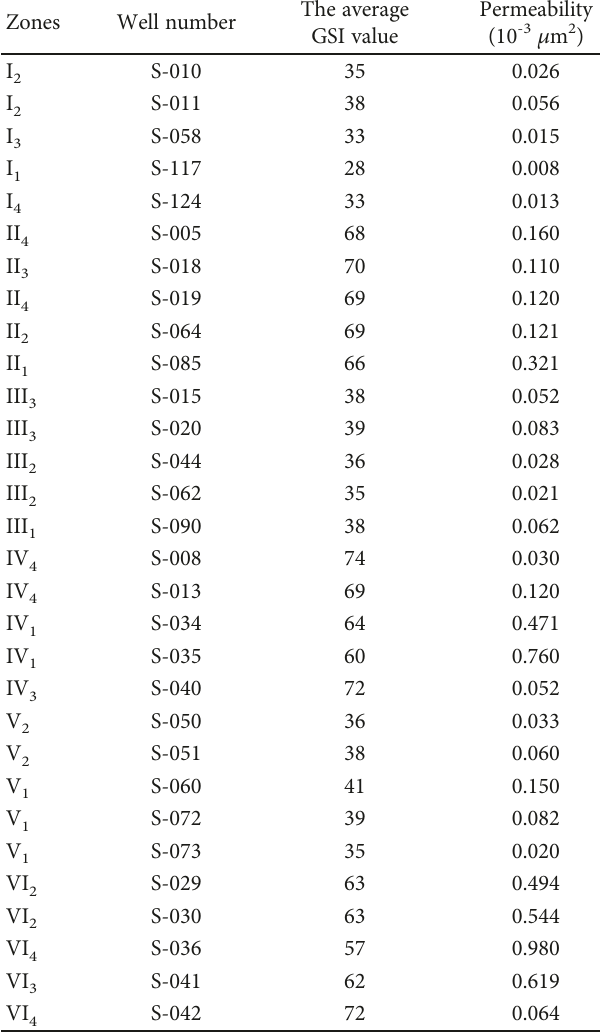
Table 1: The average GSI value and permeability of partial CBM wells in di ff erent structural superposition zones.